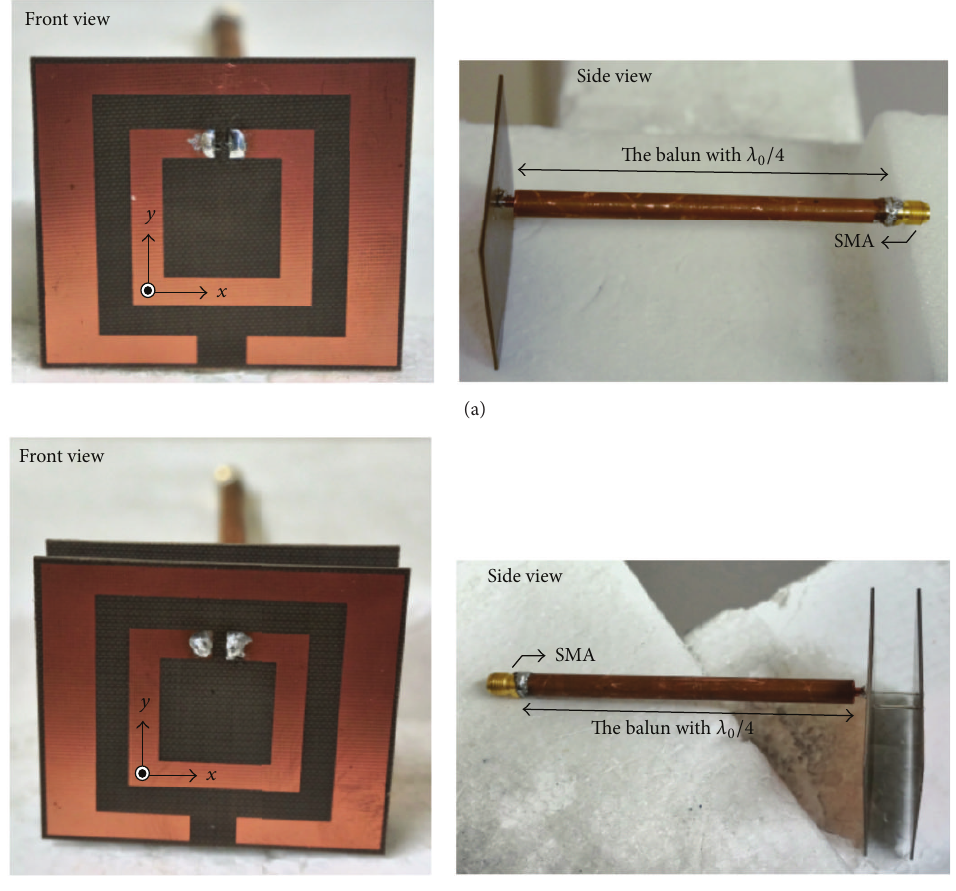
Figure 2: Photograph of fabricated prototype antenna (a) without ground plane and (b) with ground plane in perspective views and side views. Each structure has the feeding cable and the balun.